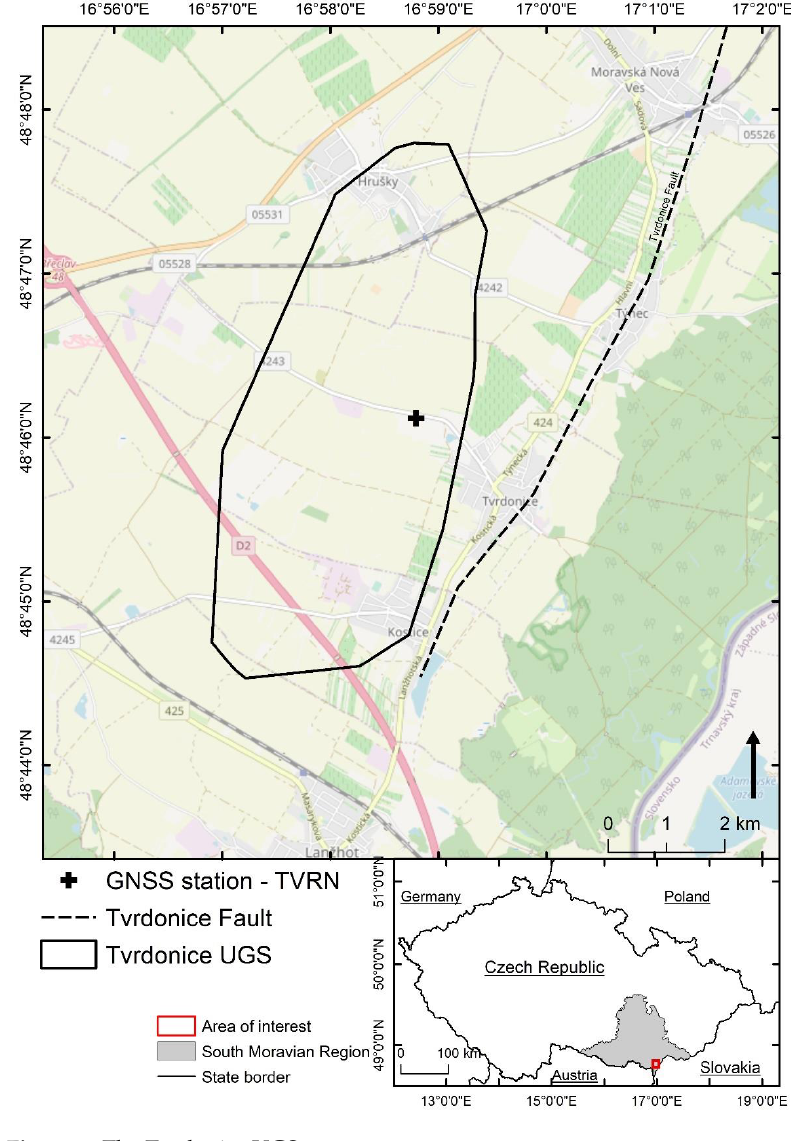
Figure 1. The Tvrdonice UGS.